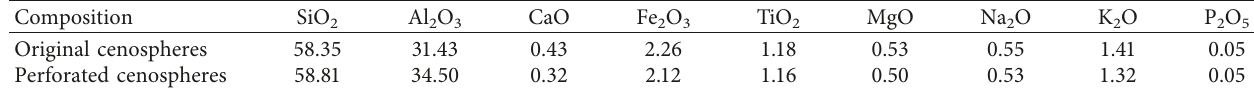
Table 3: The main chemical composition of cenospheres before and after chemical corrosion (wt.%).